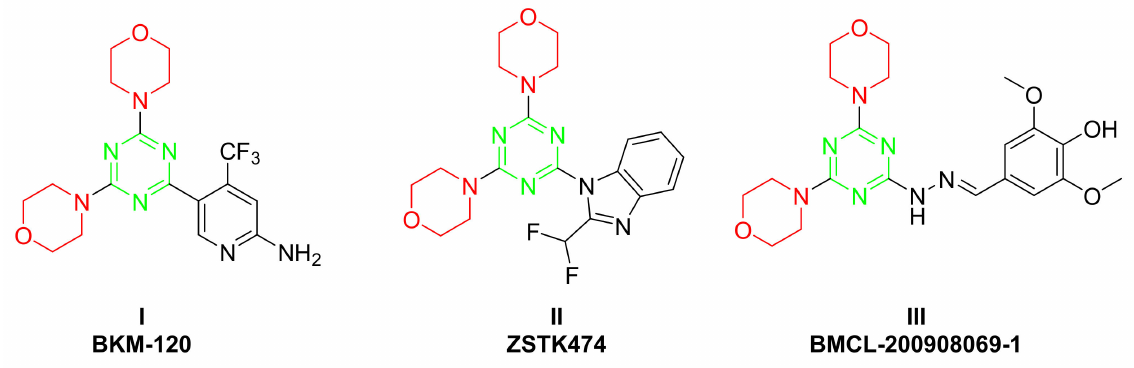
Figure 1. Anticancer s-triazine drugs ( I–III ) in phase III clinical